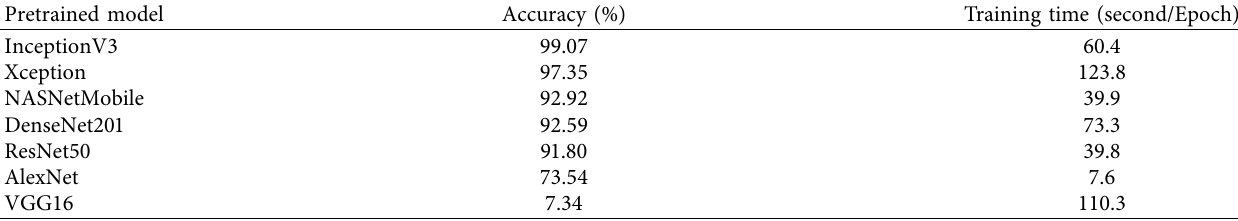
Table 1: Training time comparison of all models in the main dataset.